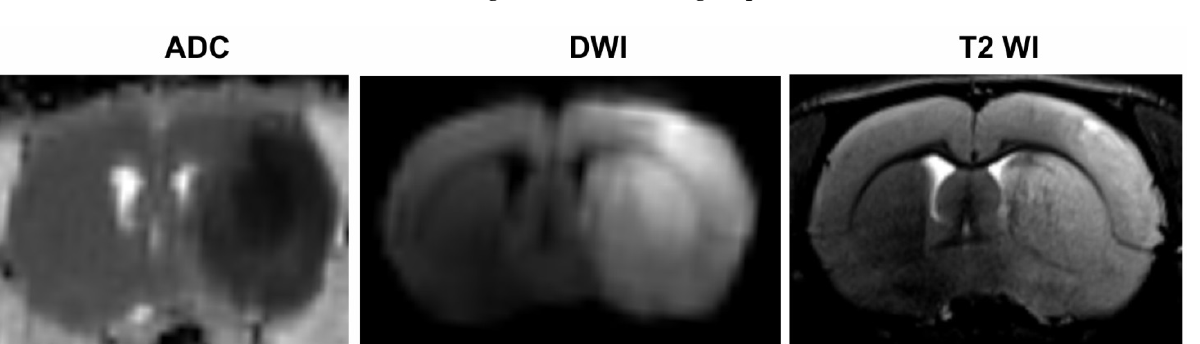
Figure 1. MRI of ischemic foci after tMCAO. DWI with an ADC map and T2 WI scans of the formation of ischemic injury areas with ipsilateral hemispheric (subcortex plus cortex) localization in the brain of rats at 24 h after tMCAO. Concomitantly, no pathological changes in the CH of ischemic rats observed according to the MRI data.